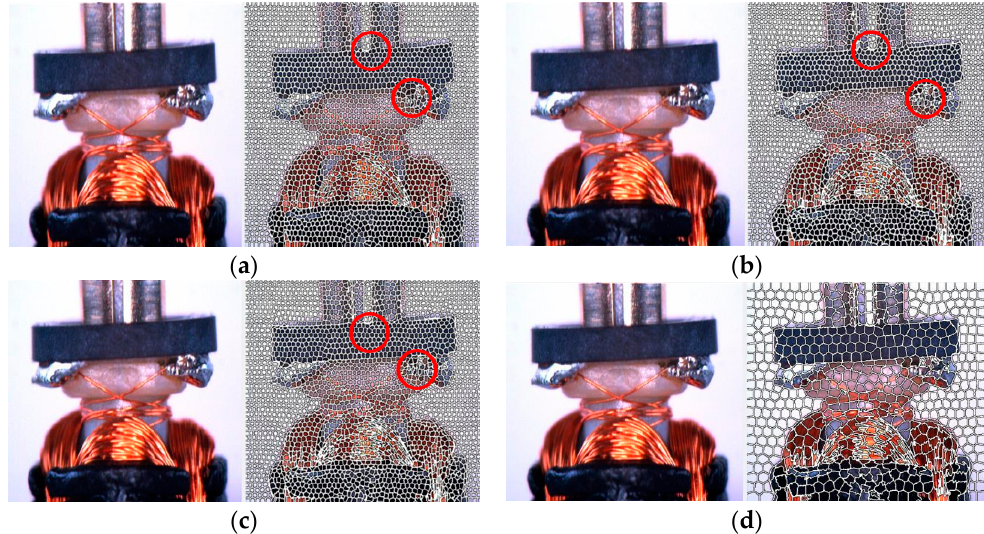
Figure 2. ( a ) and ( b ) The results of same initial value of the center points with 10 and 15 iterations respectively. ( b ) and ( c ) The results of same numbers of iterations with different initial values of the center points. ( d ) The result description of bigger size of superpixel cells.